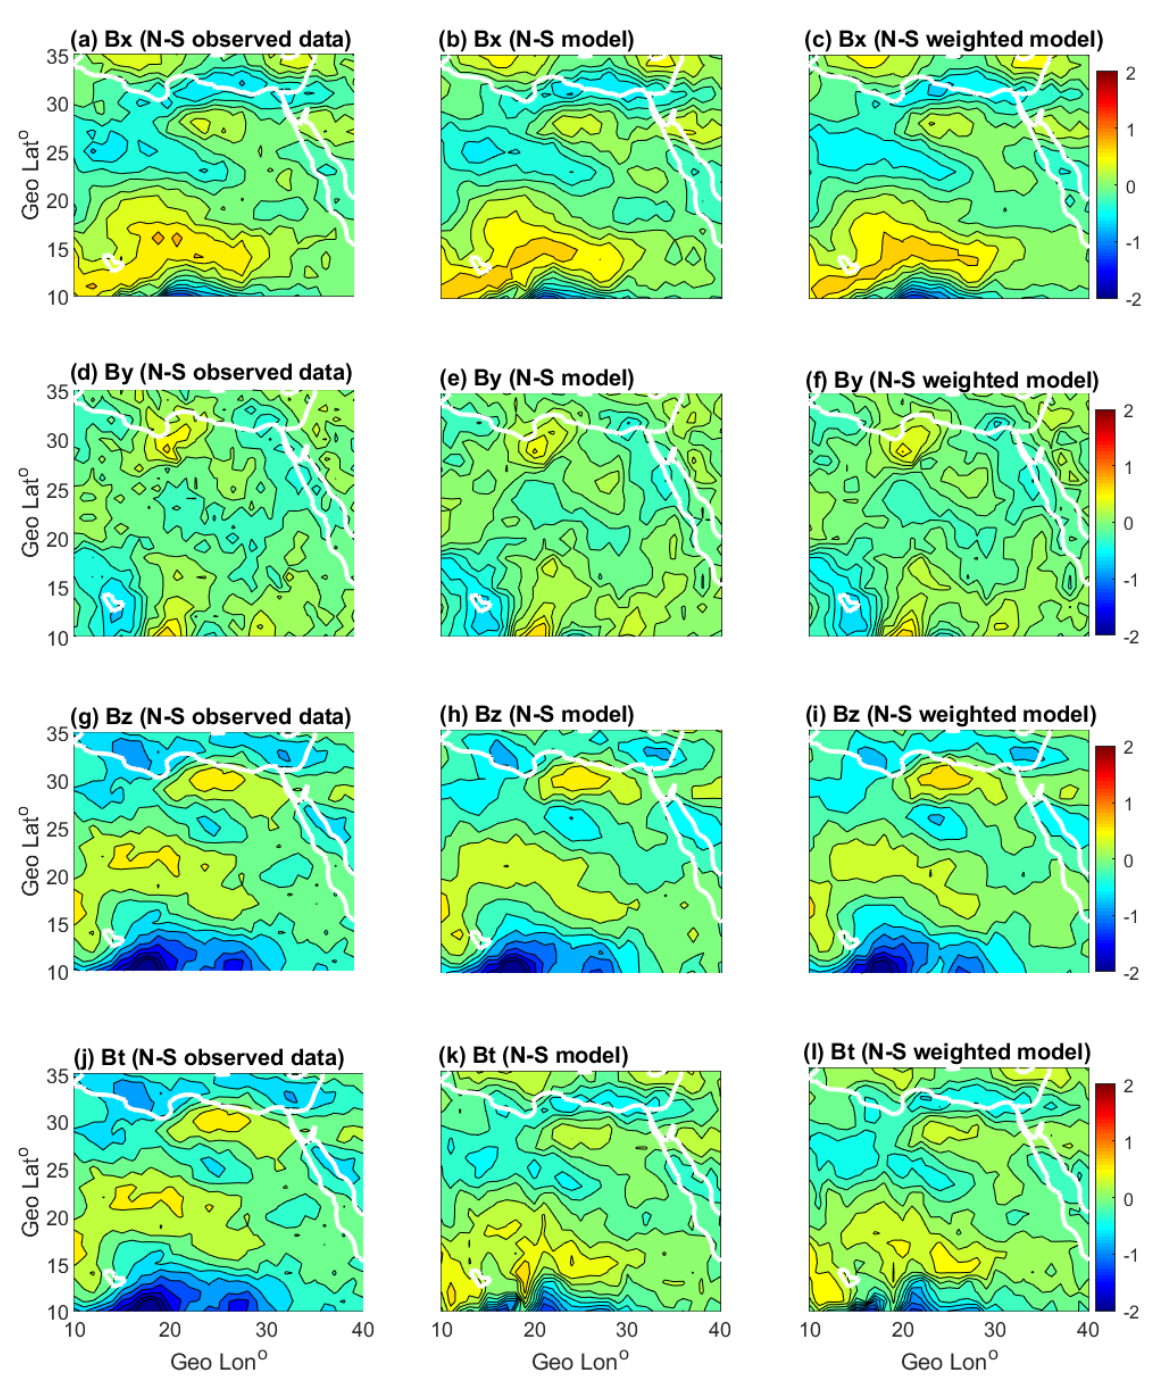
Figure 7. Same like Figure 6 but for N-S direction.